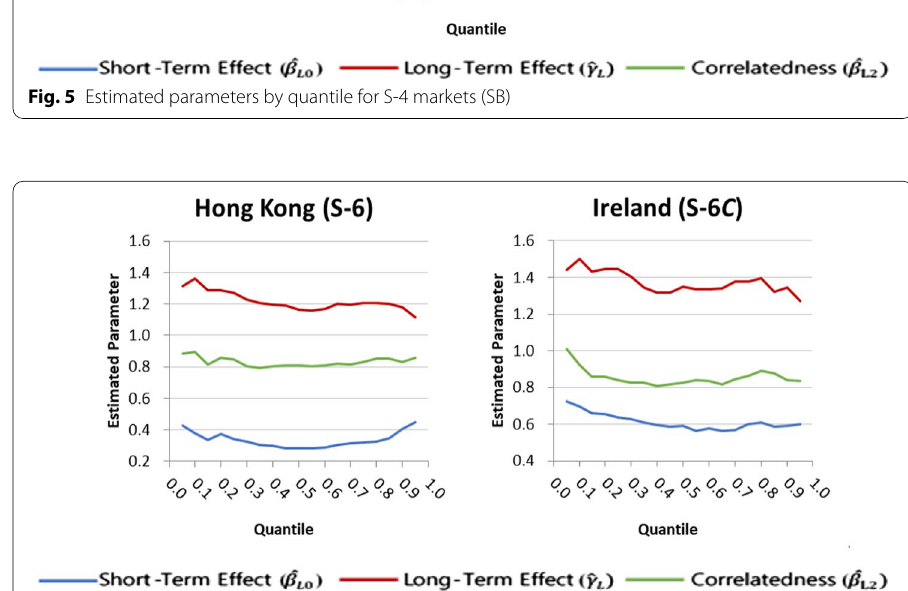
Fig. 6 Estimated parameters by quantile for S-6 markets (SB and